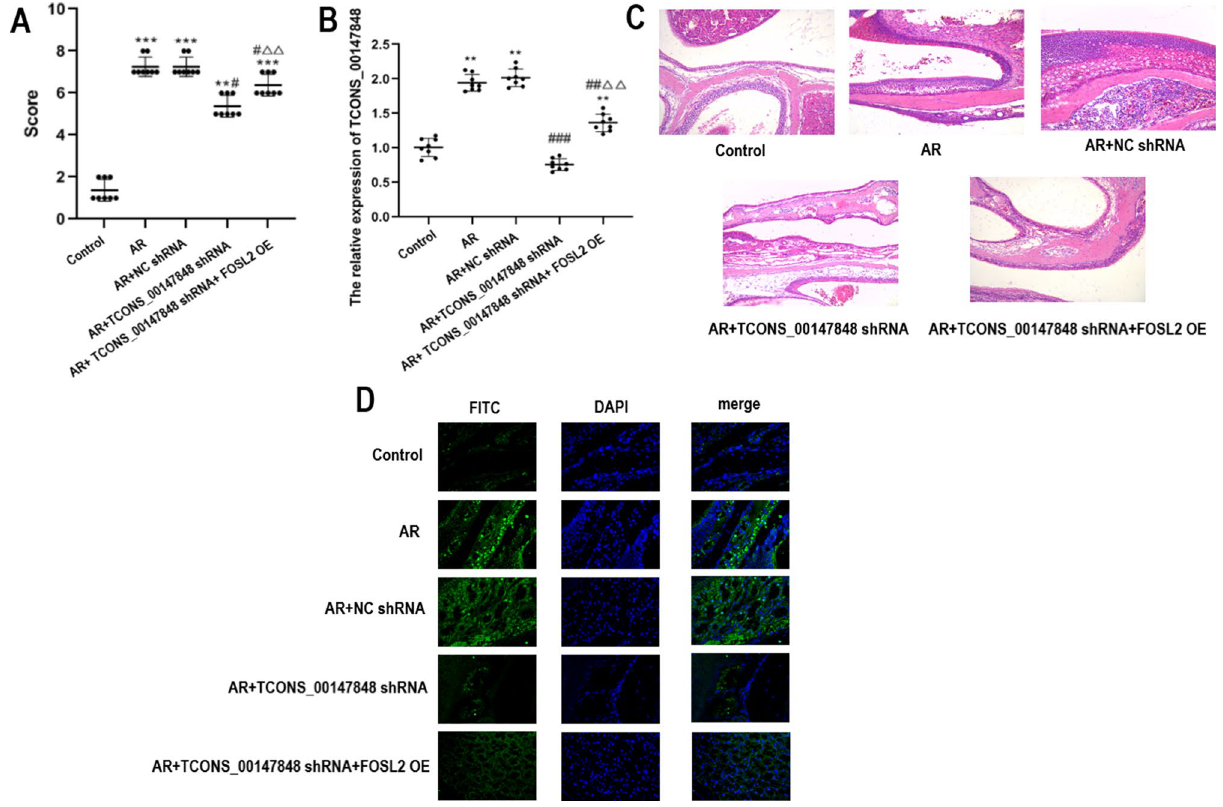
Figure 2. TCONS_00147848 and FOSL2 regulated allergic reaction symptom score, TCONS_00147848 expression, nasal mucosa histopathology, and apoptosis in mice. ( A ) Anaphylaxis symptom score of mice in each group. ( B ) Expression of TCONS_00147848 detected by RT-PCR. ( C ) Pathological changes in nasal mucosa of mice detected by HE staining. ( D ) Apoptosis in nasal mucosa of mice detected by TUNEL staining. ** P < 0.01 vs. Control group, *** P < 0.001 vs. Control group, # P < 0.05 vs. AR group, ## P < 0.01 vs. AR group, ### P < 0.001 vs. AR group, △△ P < 0.01 vs. AR + TCONS_00147848 shRNA group (Software version: SPSS